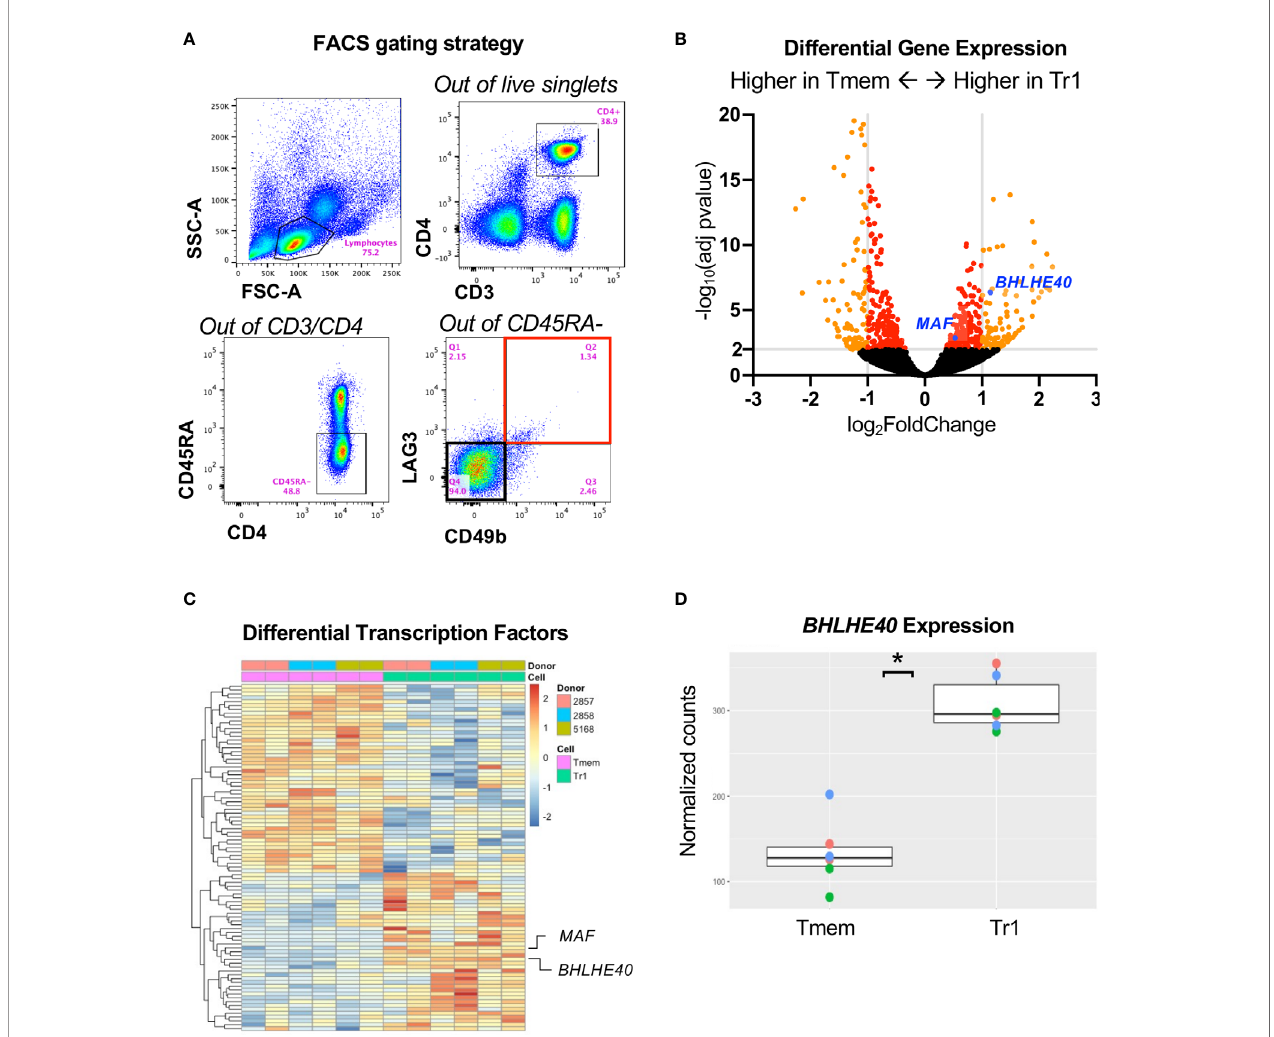
FIGURE 1 | RNA sequencing identi fi es BHLHE40 in Tr1 cells. (A) Sorting strategy for ex vivo human Tr1 cells. Healthy donor PBMCs were gated for CD3 + /CD4 + / CD45RA - . Tr1 cells were additionally gated and sorted for LAG3 + /CD49b + , indicated with a red bounding box, while non-Tr1 Tmem cells were sorted for LAG3 - / CD49b - , indicated with a black bounding box. (B) Volcano plot of differentially expressed genes between Tr1 and non-Tr1 Tmem cells. Dots indicate individual genes, with genes having an adjusted p value < 0.05 indicated in red and with genes with also an abs(log2(fold change)) > 1 in orange. MAF ( cMAF) and BHLHE40 are indicated with blue dots. (C) Differentially expressed transcription factors between Tr1 and non-Tr1 Tmem cells with an adjusted p value < 0.05 are plotted by rows and CD4 + T cell samples by columns. Fill color is z-scaled per gene. (D) Normalized counts (variance stabilized normalized counts) of BHLHE40 gene expression between Tr1 and non-Tr1 Tmem cells. *adjusted p value < 0.05 after Benjamini – Hochberg multiple testing correction. n = 3 healthy donors, biological duplicates for Tr1 and Tmem cells. Tmem, non-Tr1 T